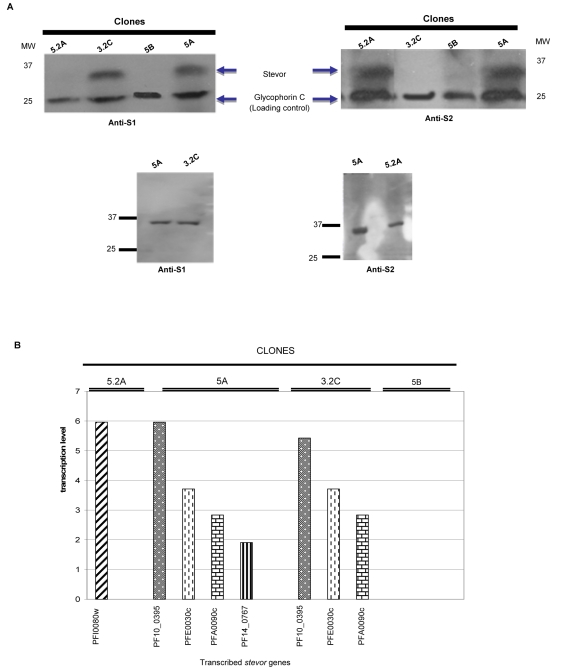
Transcription and expression analyses of STEVOR.(A) Immunoblotting of carbonate-insoluble pellet integral membrane proteins of schizont extracts of clones 5A, 5B, 3.2C, and 5.2A. A protein band of approximately 35 kDa was detected by anti-S1 serum in clones 5A and 3.2C (upper left panel) and by anti-S2 serum in clones 5A and 5.2A (upper right panel). Mouse anti-glycophorin C antibody recognizing a protein band of 25 kDa was used as loading control. Molecular weight comparison of detected STEVOR proteins by anti-S1 (lower left panel) and anti-S2 (lower right panel) is also shown. Secondary anti-rabbit (or mouse) IgG horseradish peroxydase-conjugated antibodies (Bio-Rad) and West Pico chemiluminescence (Pierce) were used to visualize the detected proteins in photographic film. Molecular marker (MM, Biorad) used for protein size comparison is shown. (B) Microarray analysis of the expression profile of transcribed stevor genes at mid-trophozoite stage (22–28 hours post invasion) of each clone. Level of transcription was determined in relation to a pool of RNA as described in Materials and Methods. Individual stevor genes with regulated transcription are shown by their accession number.